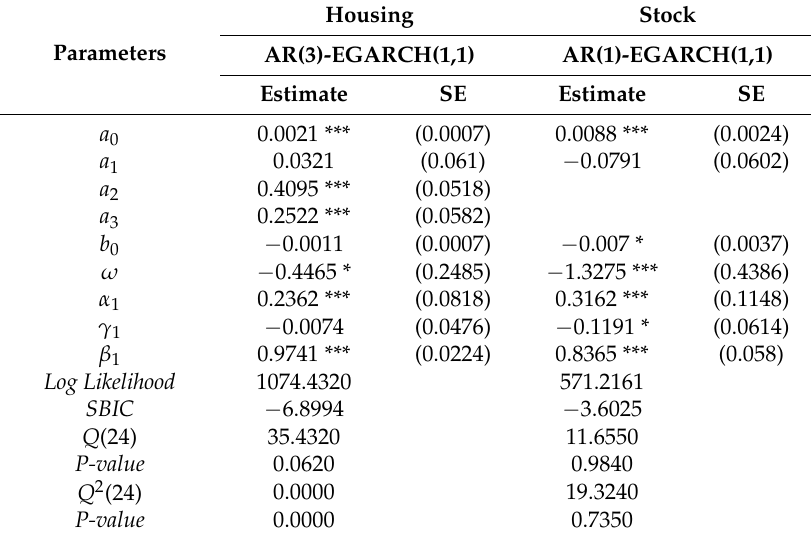
Table 4. AR-EGARCH (autoregressive-exponential generalized autoregressive conditional heteroskedasticity) model. Housing Stock Parameters AR(3)-EGARCH(1,1) Estimate SE